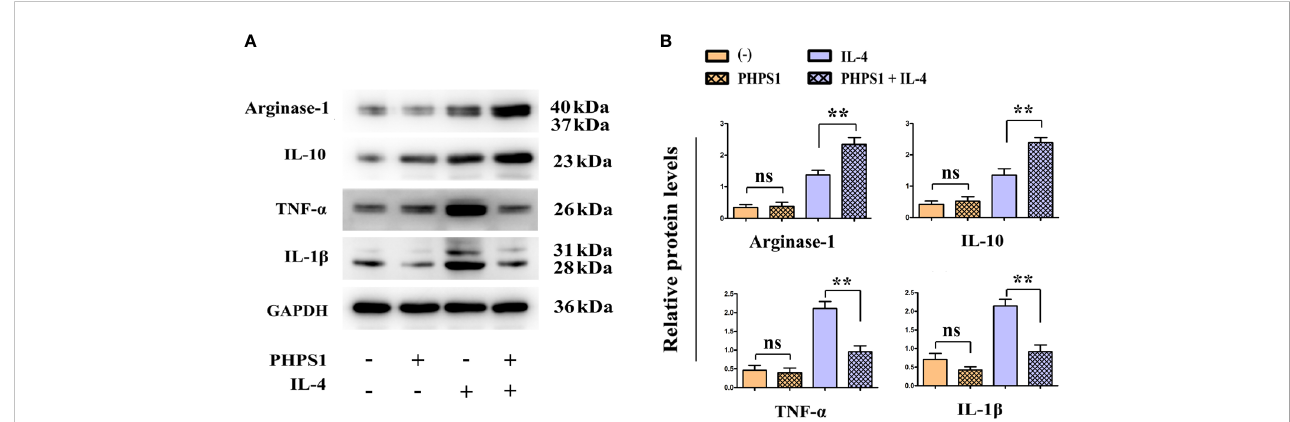
FIGURE 5 Low SHP-2 expression promoted the protein levels of Arginase-1 and IL-10 and inhibited those of IL-1 b and TNF- a in M2 macrophages. (A) Western bolt was used to detect the protein levels of Arginase-1, IL-10, IL-1 b and TNF- a ; (B) Quantitative analysis of the protein expression of Arginase-1, IL-10, IL-1 b and TNF- a . ns indicated no statistical difference; ** P <0.01 indicated vs. IL-4 group. All experiments were independently repeated three times. SHP-2, Src homology region 2 domain-containing protein tyrosine